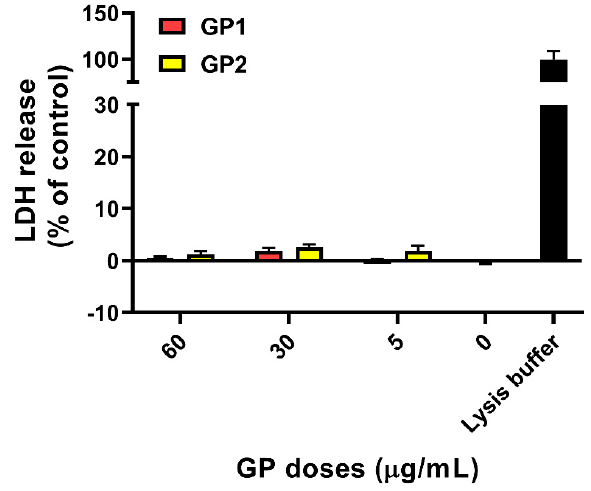
Figure 1. LDH release from THP-1 cells after 40 h of exposure to GP. Data are reported as mean ± standard deviation. LDH release (%) was calculated according to the absorbances of untreated cells (0 µg/mL) and positive control (lysis buffer).